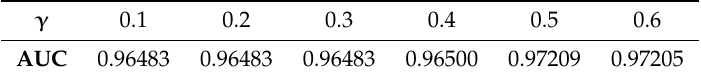
Table 2. The AUC value based on changing γ and fixed pathway maximum length.